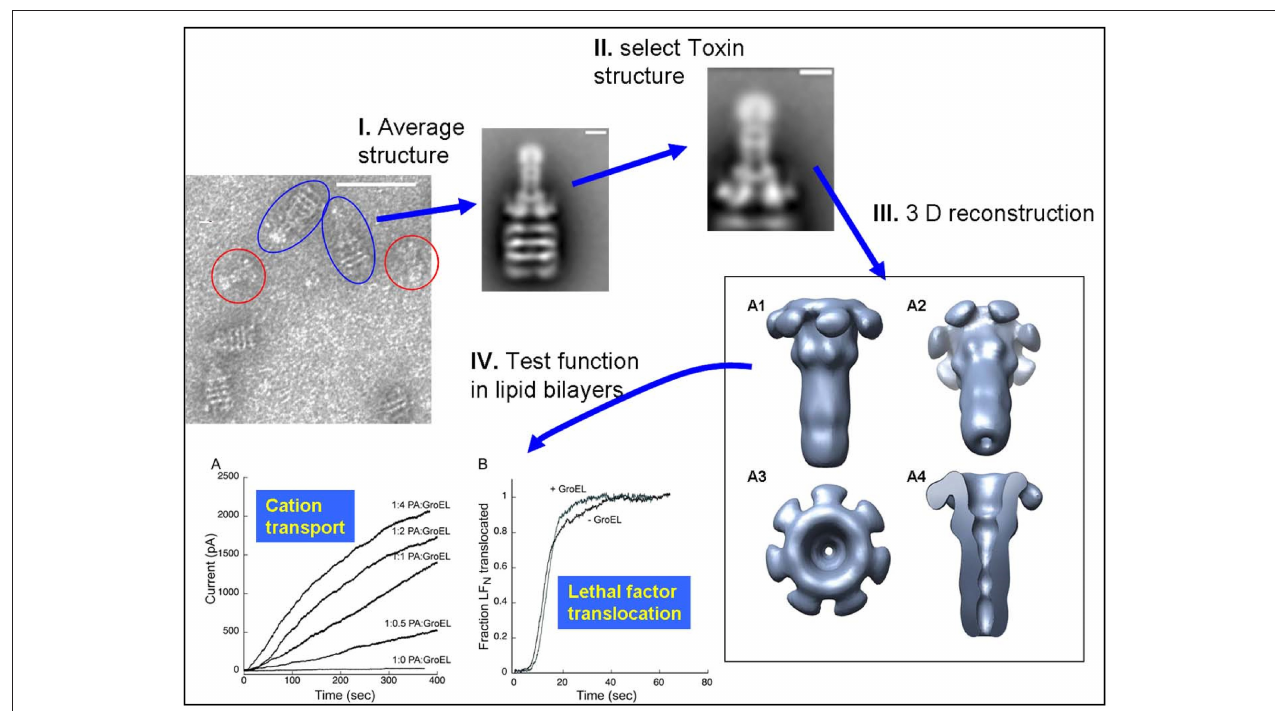
FIGURE 5 | Schematic of the Protective Antigen Anthrax Pore Capture and Conversion. (I) 2D class computational averaging of GroEL-PA pore from the micrographs. (II) Masking of 2D class averages to reconstruct PA pore alone. (III) 3D envelope of isolated PA pore reconstructed using SPIDER, revealing the long β -barrel pore. (IV) PA pore functionality was as tested by both (A) cation transport and (B) lethal factor translocation assays. Micrographs obtained at UMKC. Adapted from Katayama et al. (2008).